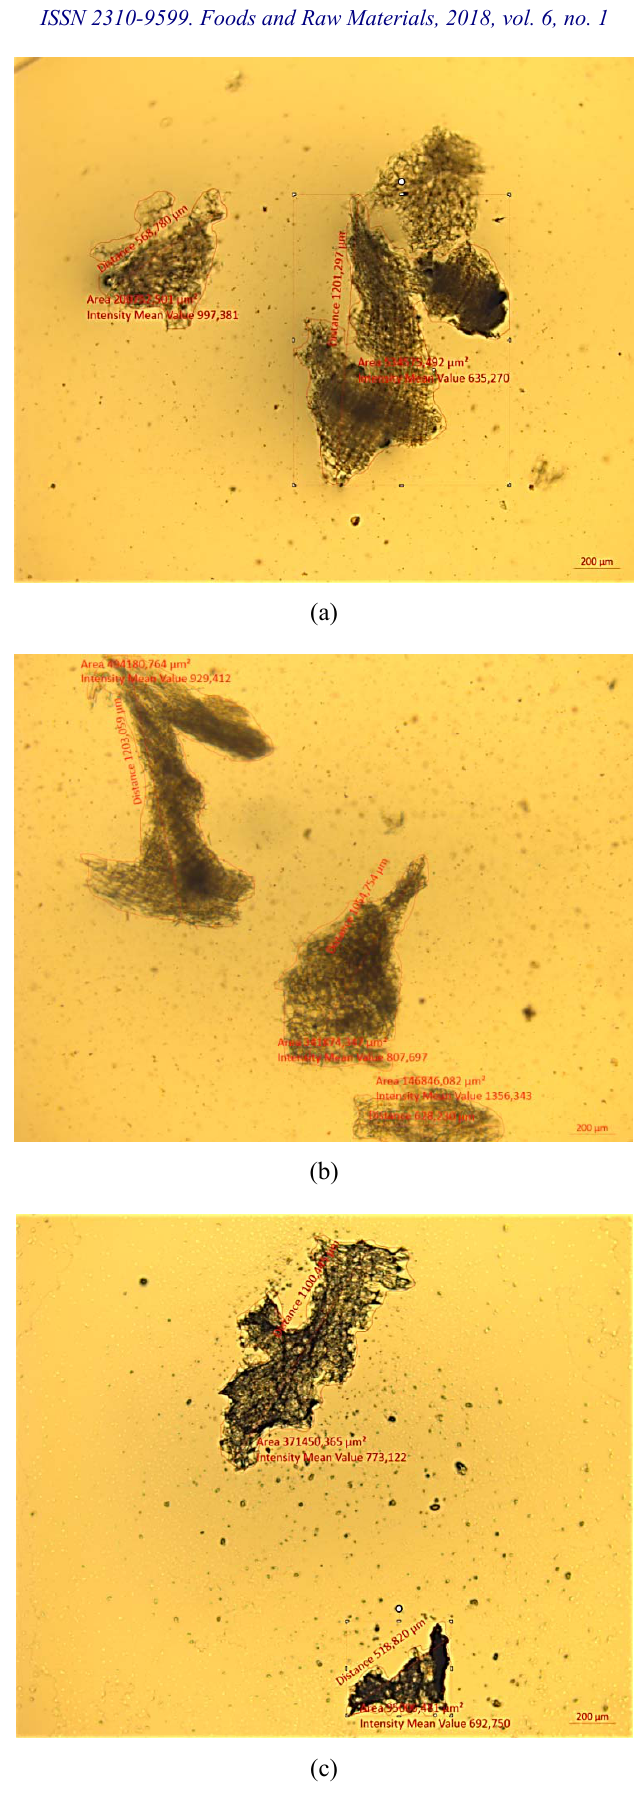
Fig. 8. Fermented carrot pulp, a 200-fold increase: (a) Nantes variety carrots, (b) Forto variety carrots, (c) Toucheon variety